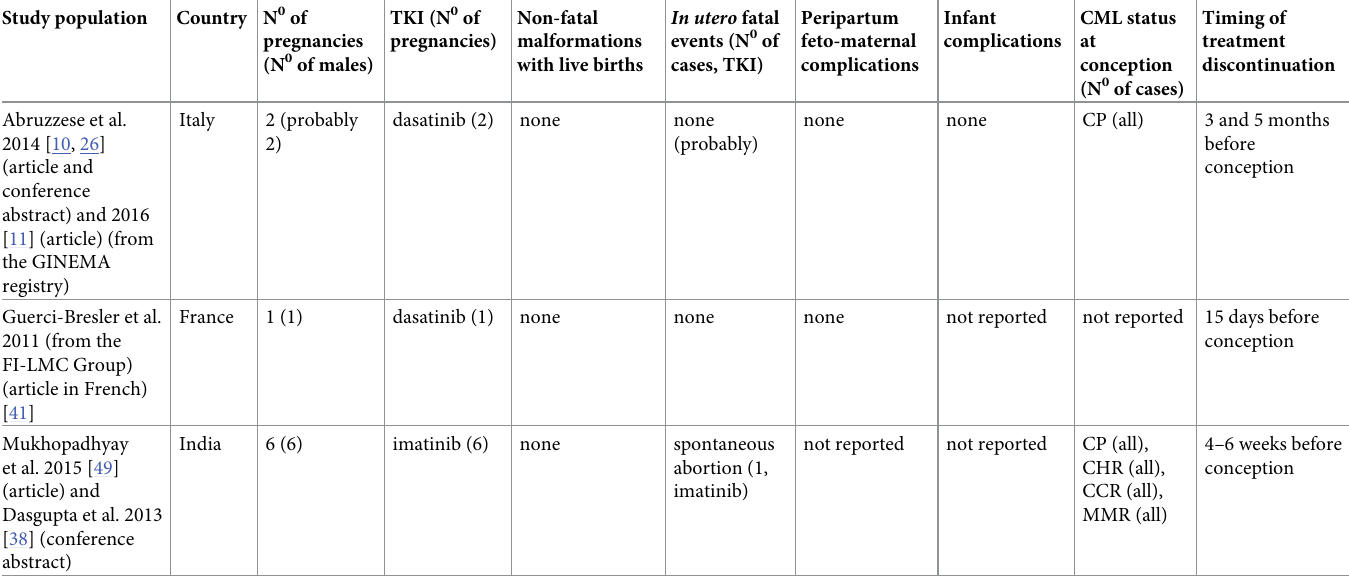
Table 1. Characteristics of the studies reporting on male patients with planned treatment discontinuation before conception. Study